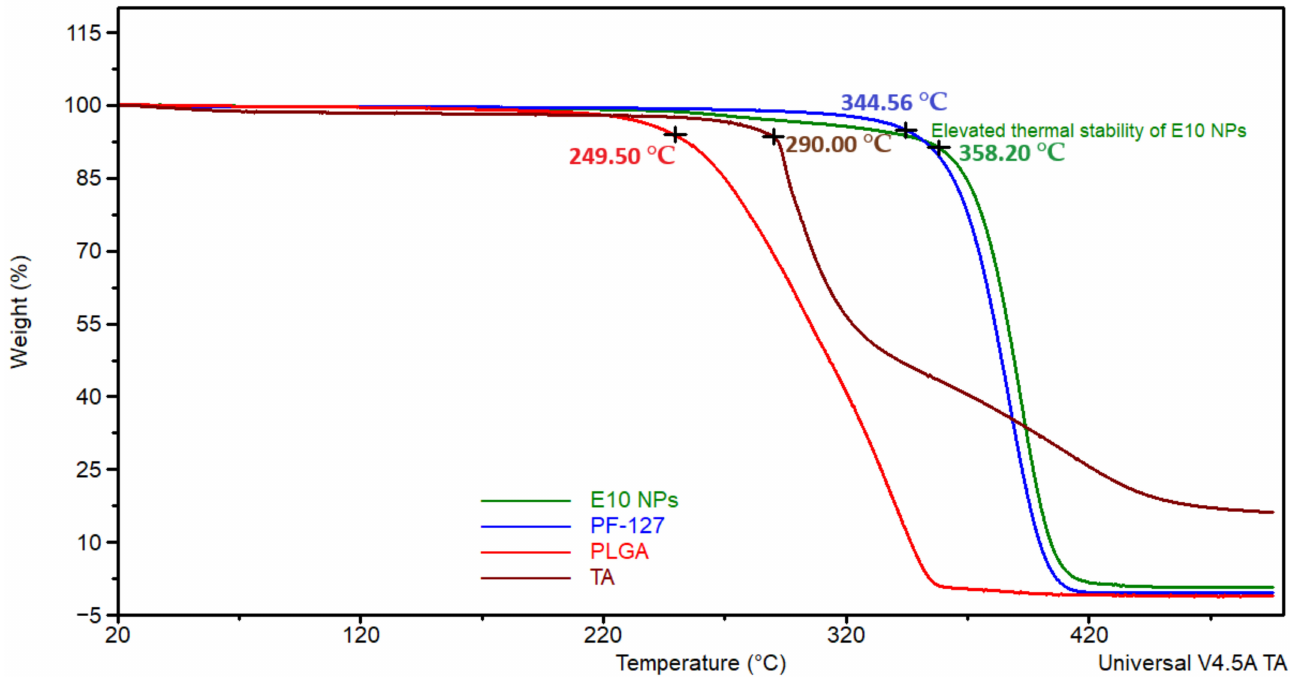
Figure 5. Thermogravimetric analysis (TGA) curves exhibiting the extended thermal stability of PLGA NPs (E10) compared to individual components (TA, PLGA and